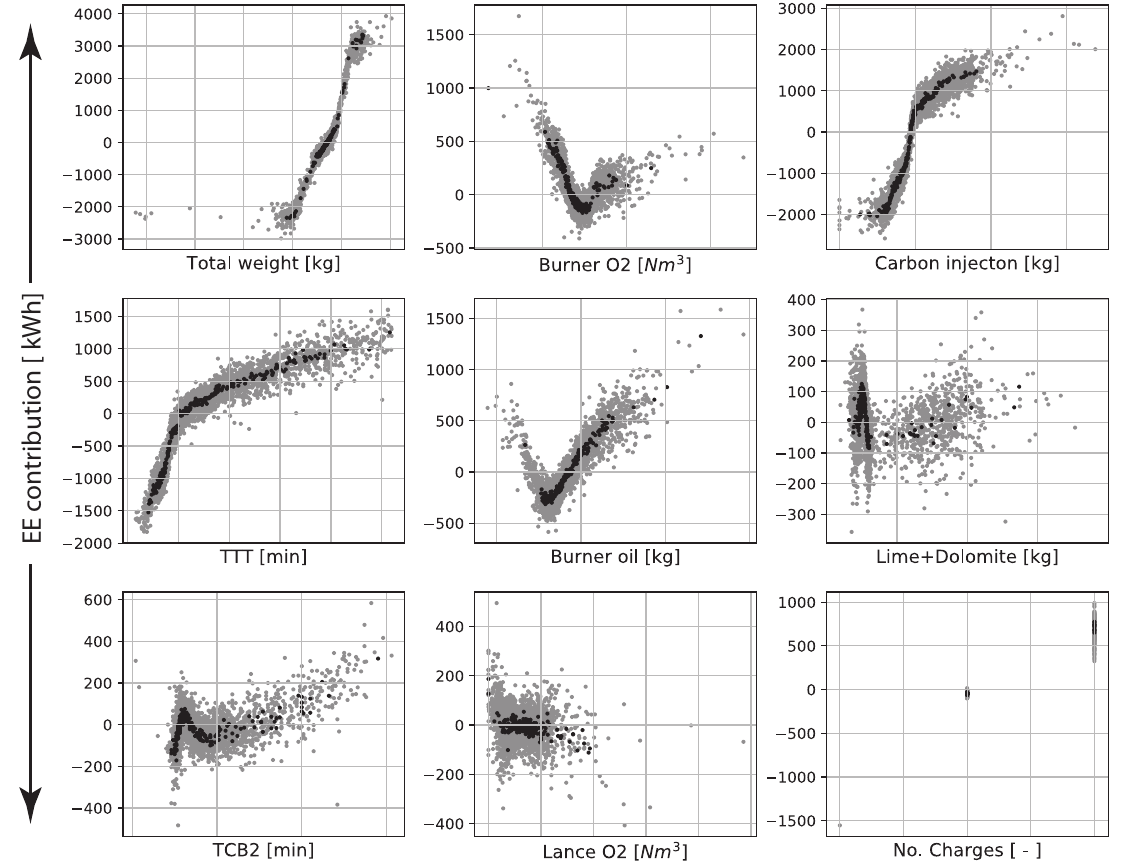
Figure 11. SHAP Main interaction effects for the base variables for the selected model. The y-axes show the main interaction effect on EE while the x-axes show the increasing amount of each variable. See Table 2 for details about the definition of each variable. The values on the x-axes has been omitted due to proprietary reasons. The grey dots represent values from the training data and the black dots represent values from the test